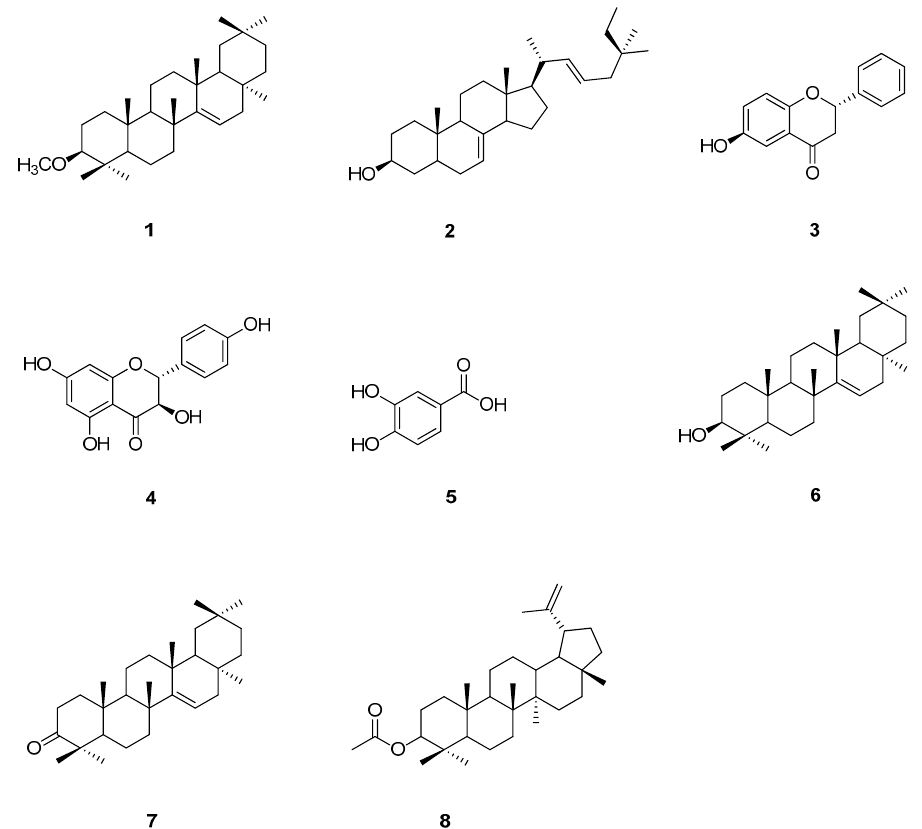
Figure 1. Chemical structures of isolated compounds from M. zapota bark: taraxerol methyl ether ( 1 ); spinasterol ( 2 ); 6-hydroxyflavanone ( 3 ); ( + )-dihydrokaempferol ( 4 ); 3,4-dihydroxybenzoic acid ( 5 ); taraxerol ( 6 ); taraxerone ( 7 ); and lupeol acetate ( 8 ).